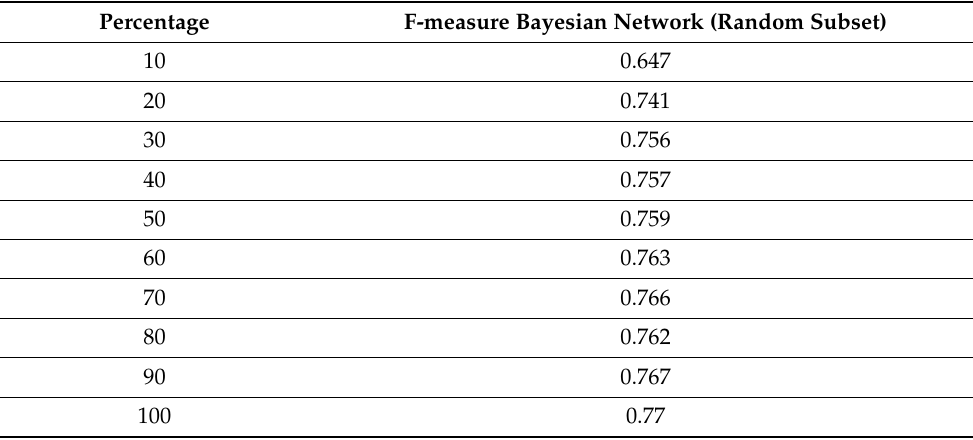
Table 4. F ‐ measure for Bayesian Network with a random subset. Table 4. F-measure for Bayesian Network with a random